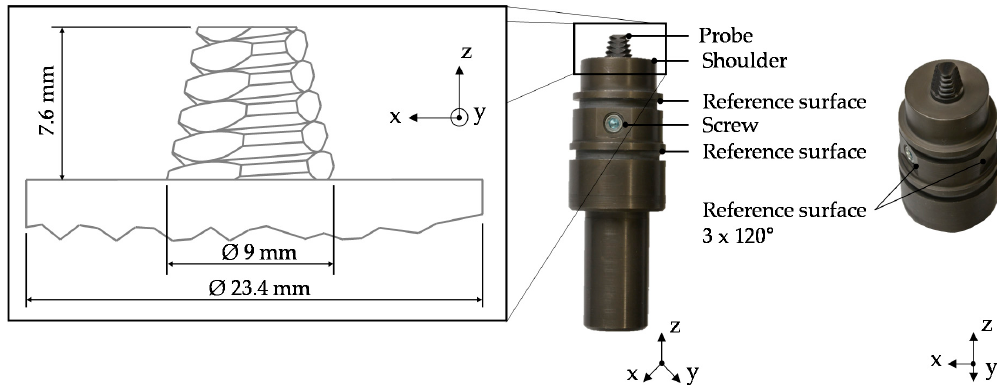
Figure 1. Dimensions of the tool.